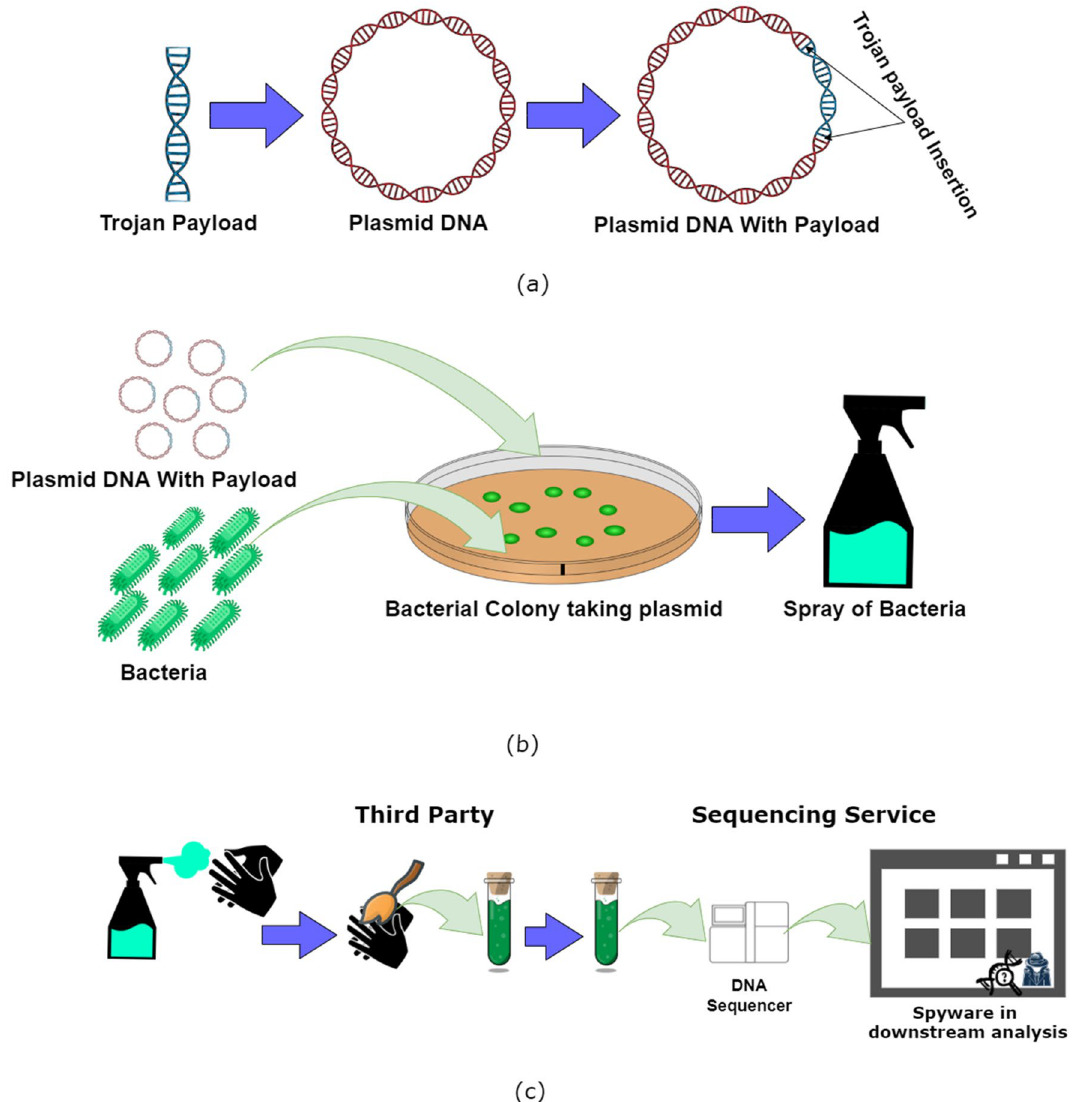
Figure 2. Trojan Bio-Cyber Hacking: Payload Preparation and Attack Scenario example using DNA plasmids. ( a ) A Trojan payload (using encryption and steganography) is encoded into a DNA sequence which is